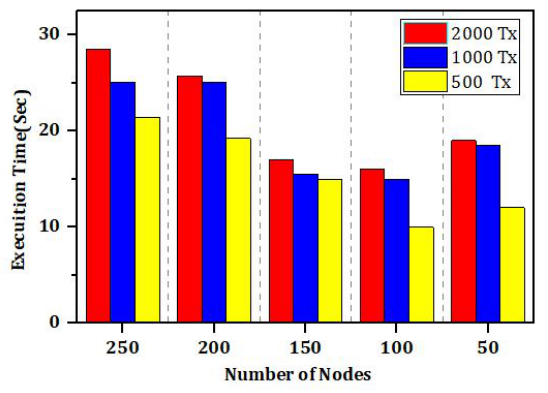
Figure 23. The impact of number of nodes on execution time and number of Transactions